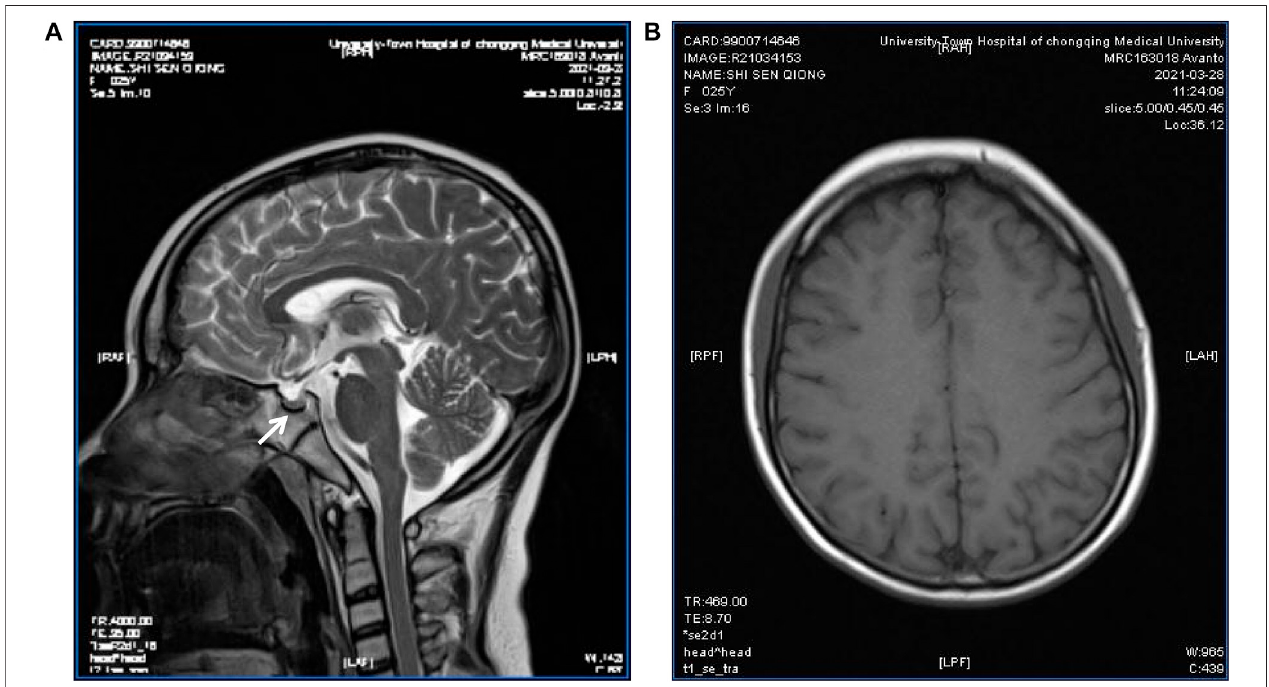
FIGURE 3 | Pituitary MRI of the patient. T2-weighted MR imaging for the patient showed a partially empty sella and a small pituitary gland (arrow) (A) ; Magnetic sensitivity weighted imaging showed no abnormal iron deposition accumulation (B) .